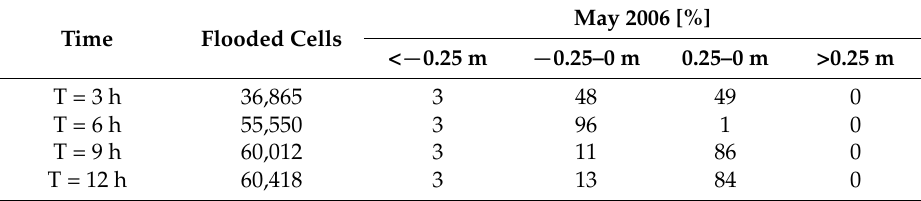
Table 6. Percentage of cells inundated at the convective event in May 2006.